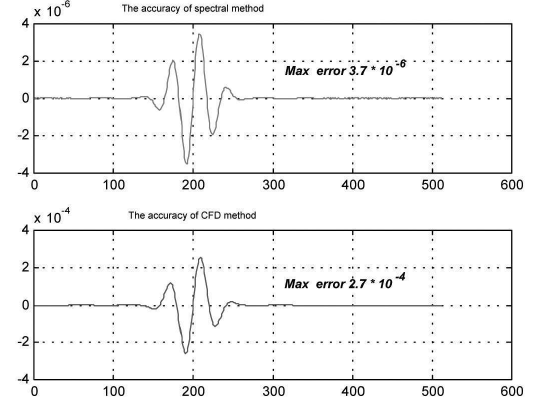
Figure 7. Comparison of CFD and spectral approximations for the first derivative of the test signal